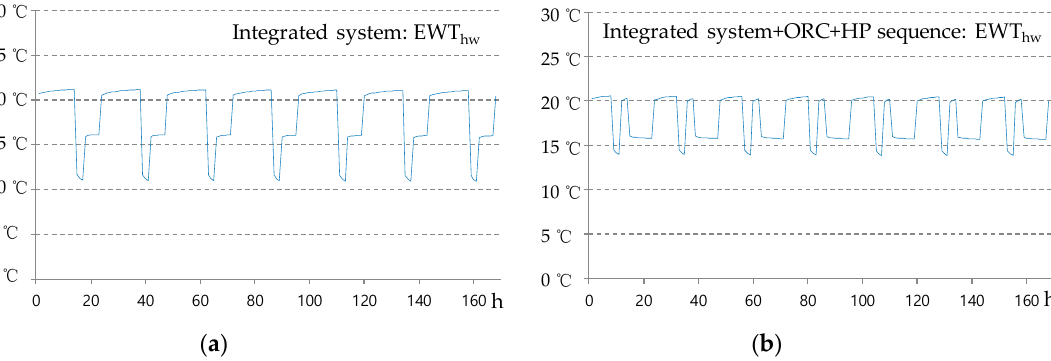
Figure 11. ( a ) EWT hw of the integrated system; ( b ) that with OARC in sequential operation (right) during the first week of February.